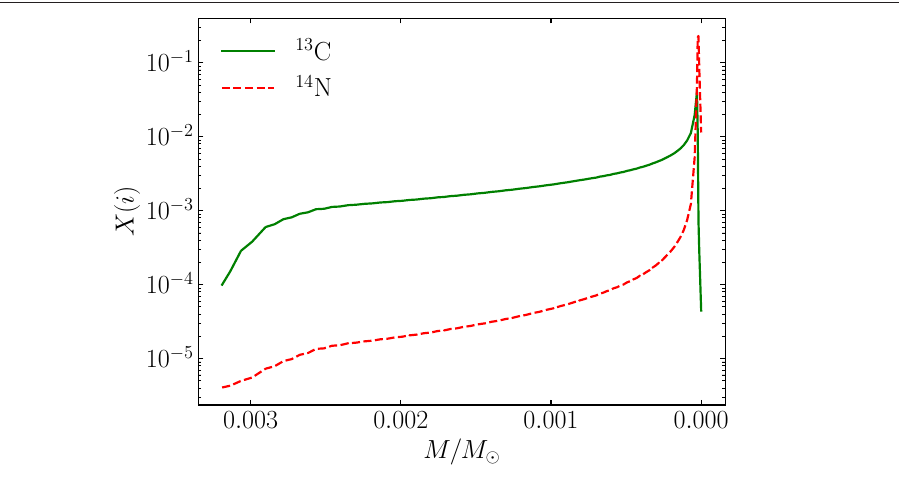
Figure 1. 13 C and 14 N abundance in the 13 C pocket region for FRUITY Magnetic